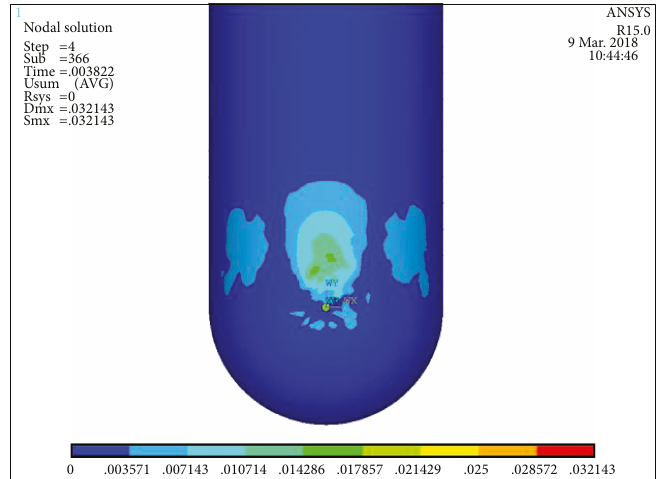
Figure 21: Displacement distribution at time of separation.